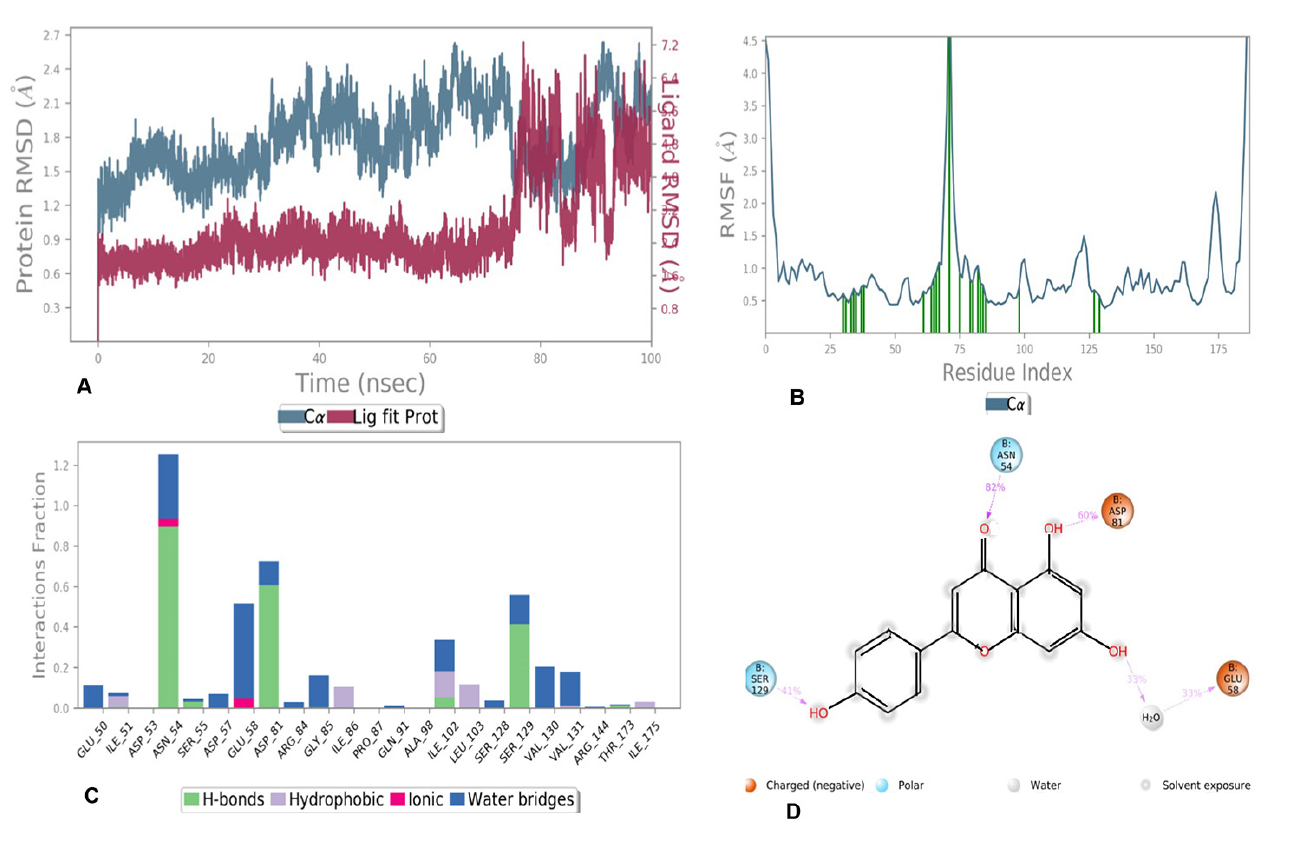
Figure 7. MD simulation results for compound 5 with receptor 5D6P: ( A ) Time-dependent protein- ligand root mean square deviation (RMSD) plots, ( B ) Root mean square fluctuation (RMSF) plots, ( C ) Simulation interactions with bar diagram indicating the fold of interaction, fraction, and contacts, and ( D ) 2D binding interactions.